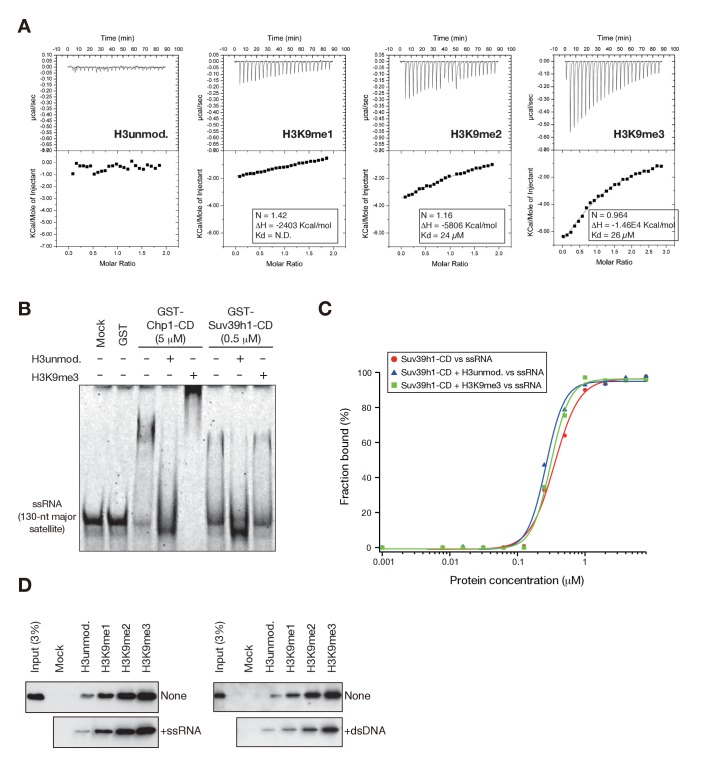
Suv39h1-CD’s RNA binding is independent of its H3K9me3 recognition.(A) Isothermal titration calorimetry (ITC) showing the binding affinities of GST-Suv39h1-CD (39–96) for unmodified H3K9, H3K9me1, H3K9me2, and H3K9me3 peptides. (B) EMSAs using GST-fused S. pombe Chp1-CD and Suv39h1-CD; GST-fused proteins were incubated with a 130-nt ssRNA probe in the presence or absence of equal molar quantities of unmodified and K9-trimethylated H3 peptides. (C) Binding isotherms of GST-Suv39h1-CD and ssRNA in the presence or absence of equal molar amounts of the indicated H3 peptides. (D) In vitro peptide-binding assay using WT Suv39h1-CD in the presence of major satellite ssRNA or dsDNA.